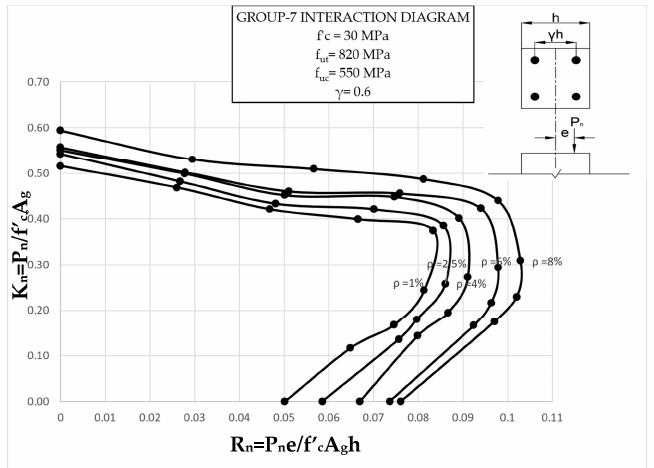
Figure 19. Group 7 interaction diagram.